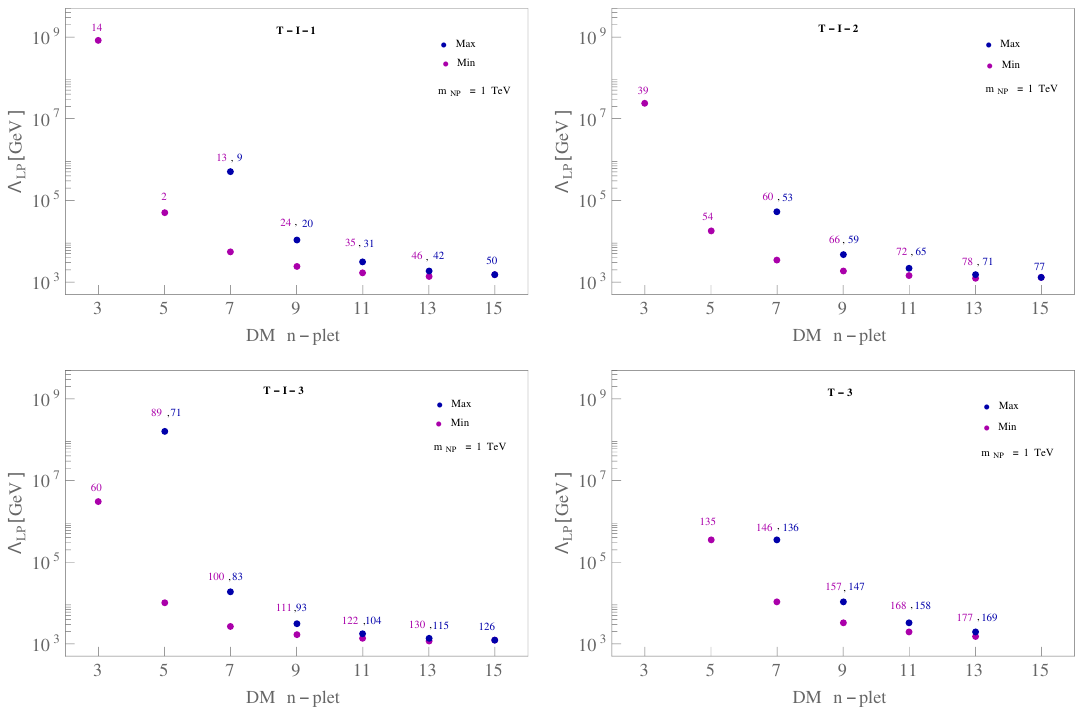
Figure 5 . For each topology and electro-weak DM representation, we show the models with the minimal (magenta points) and maximal (blue points) SU(2) -Landau pole Λ LP values. In the running of the gauge couplings all the additional fields beyond the SM are added at the scale m NP = 1 TeV. The numbers above the points refer to the specific model as listed in the DM tables in the appendix. All model numbers refer to DM-A in table 9, except the ones associated to 3-plet DM (and also model 71 of T-I-3) which belong to DM-E in table 8.